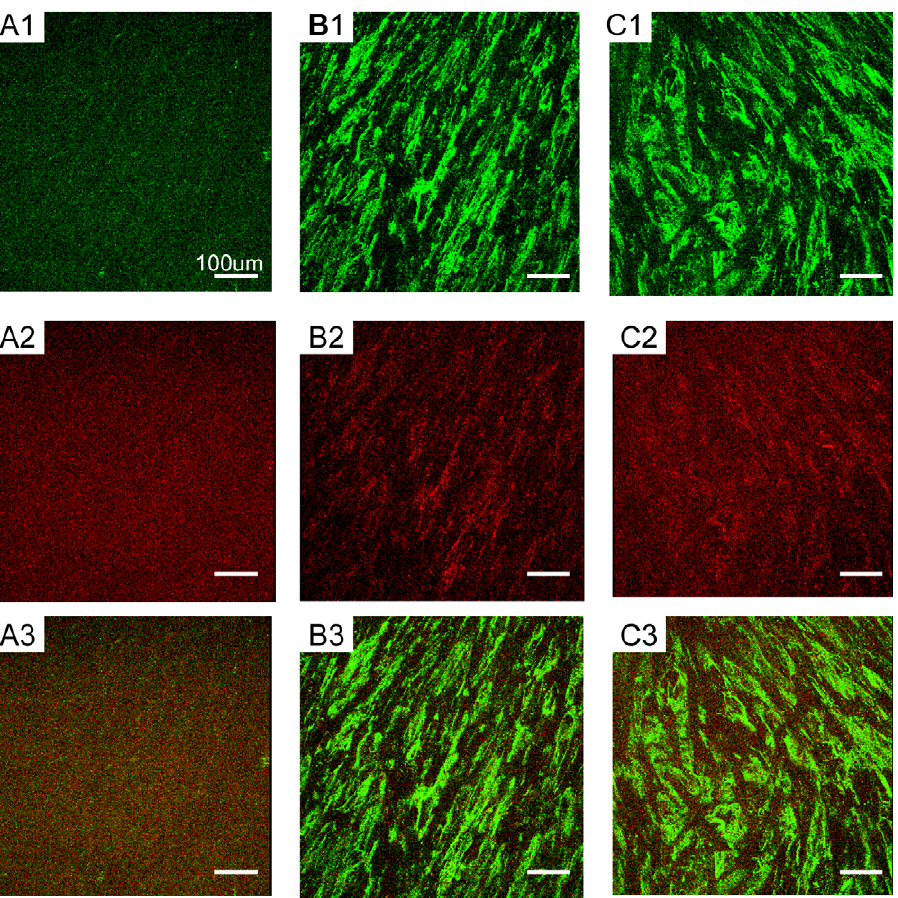
Figure 5. Type I and type III Collagens fluorescent immunostaining images of periodontal ligament fibroblasts on the different scaffolds after six weeks culture. Fluorescent immunostaining with Anti-collagen type I and Alexa fluor 488 goat anti-rabbit IgG for collagen type I (green) in A1) RADA16, B1) PRG and C1) PDS, and Anti-collagen type III and Alexa fluor 594 goat anti-mouse IgG for collagen type III (red) in A2) RADA16, B2) PRG and C2) PDS. Mix ratio of designer PRG/PDS and RADA16 scaffold is 1:9. In case of PRG and PDS, periodontal ligament fibroblasts drastically produced type I and type III collagens which were extra-cellular matrix components of periodontal ligament. The scale bar represents 100 um for all images.